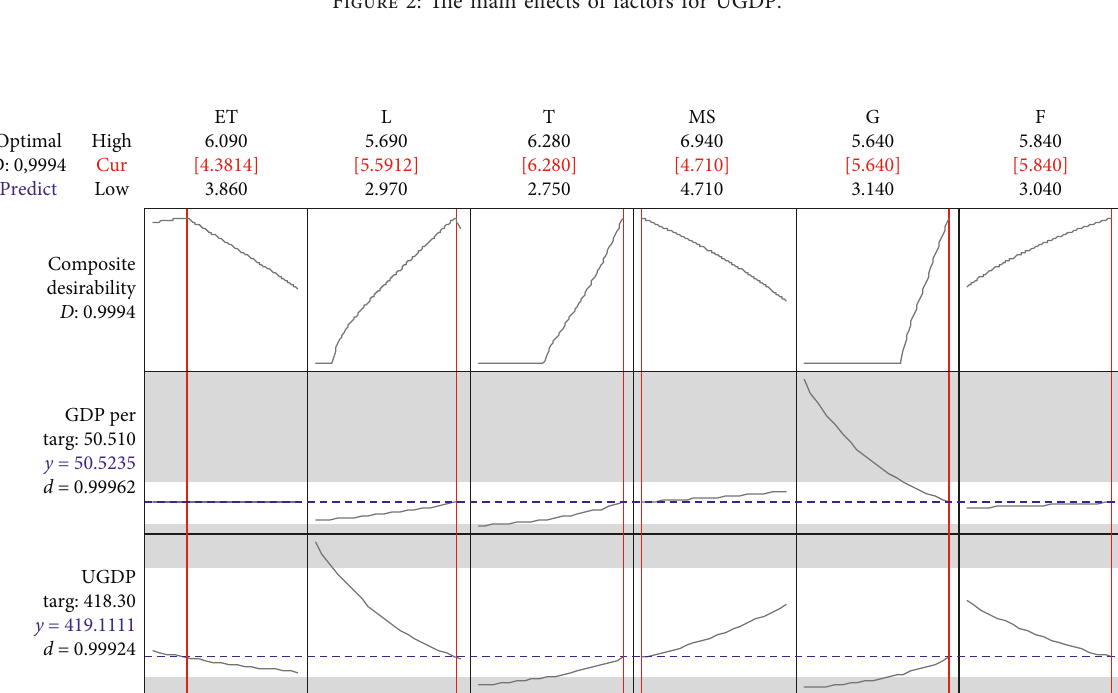
Figure 3: The optimum values of both response